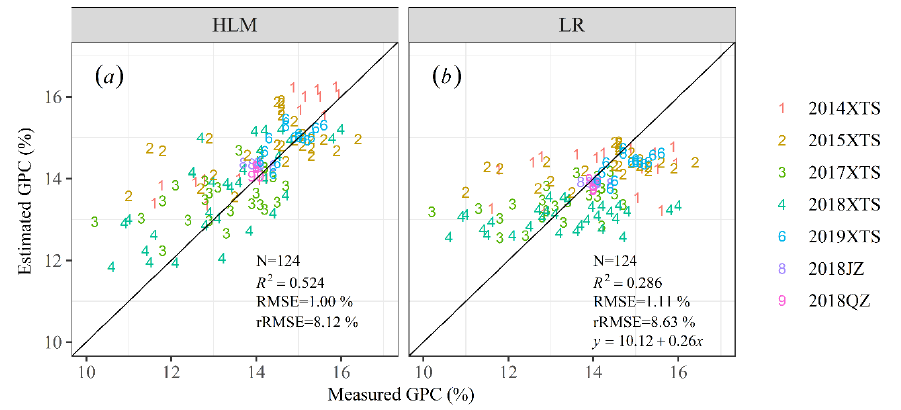
Figure 5. GPC predicting model of winter wheat based on hierarchical linear model (HLM) and linear